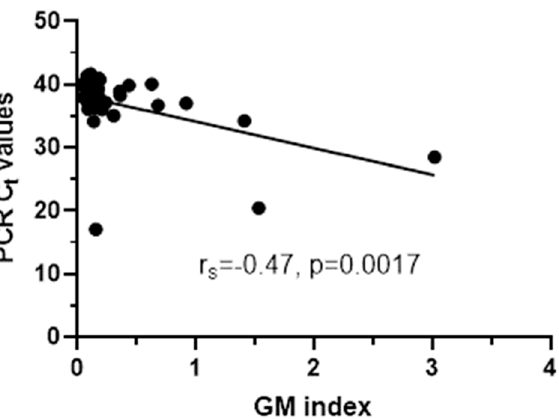
Figure 2. Significant correlation between PCR C t values and GM indices for PCR+ samples.